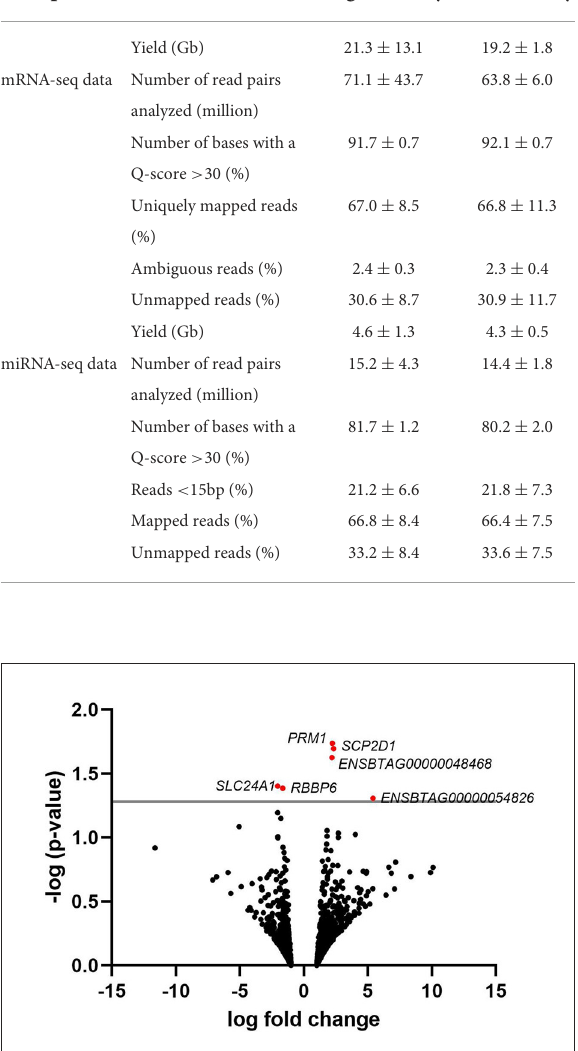
FIGURE2 Volcano plot depicting an overview of differential mRNA expression between bulls of varying fertility. The red dots indicate genes deemed significantly differentially expressed between bulls of high and low fertility. Genes with a positive log fold change were upregulated in the low fertility group. The gray horizontal line depicts the p -value threshold cut-off ( P < 0.05).